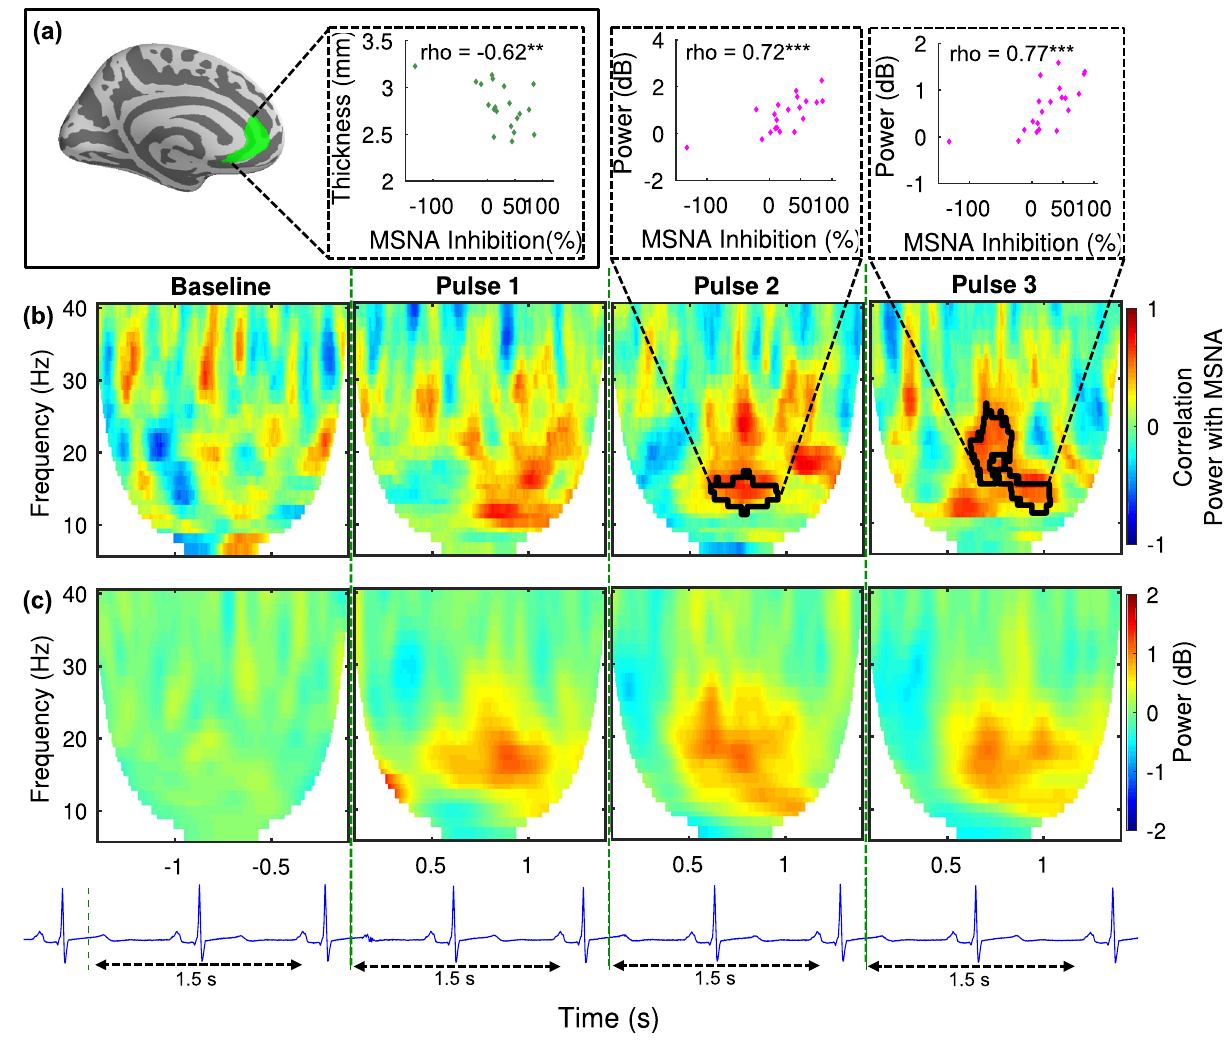
Figure 2. Structural and functional analysis of the anterior cingulate cortex. All power values are relative to the pre-stimulus baseline (n = 20). (a) (left) rostral ACC ROI, (right) correlation between cortical thickness and individual MSNA inhibition. (b) Correlations between MEG oscillatory power changes and individual MSNA inhibition overlaid with above-threshold clusters (marked with black boundaries). The correlation between average power within the clusters and MSNA inhibition for each subject is presented in the inset above the clusters for pulse 2 and pulse 3 responses. (C) Grand average MEG oscillatory power changes in the 5–40 Hz frequency range in the rostral ACC for each of the three pulses. The schematic ECG shows how stimulation was time-locked to 200 ms after the heartbeat. Spectral power analysis included 1.5 s after each stimulus due to variations in heart rate. ** p < 0.01 *** p <